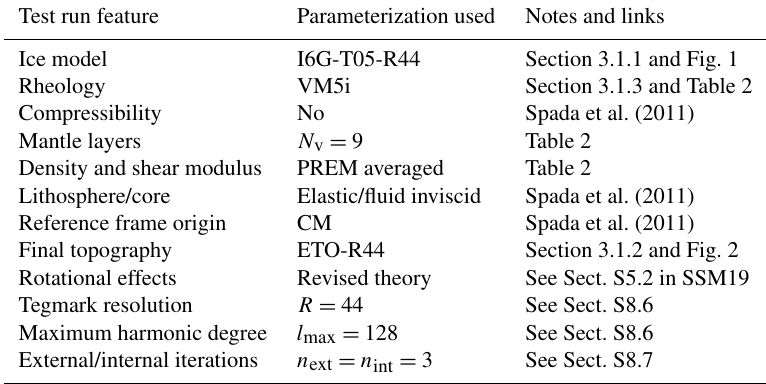
Table 1. Configuration details of the SELEN 4 test run whose results are considered in Sect. 3, with notes and links to text and